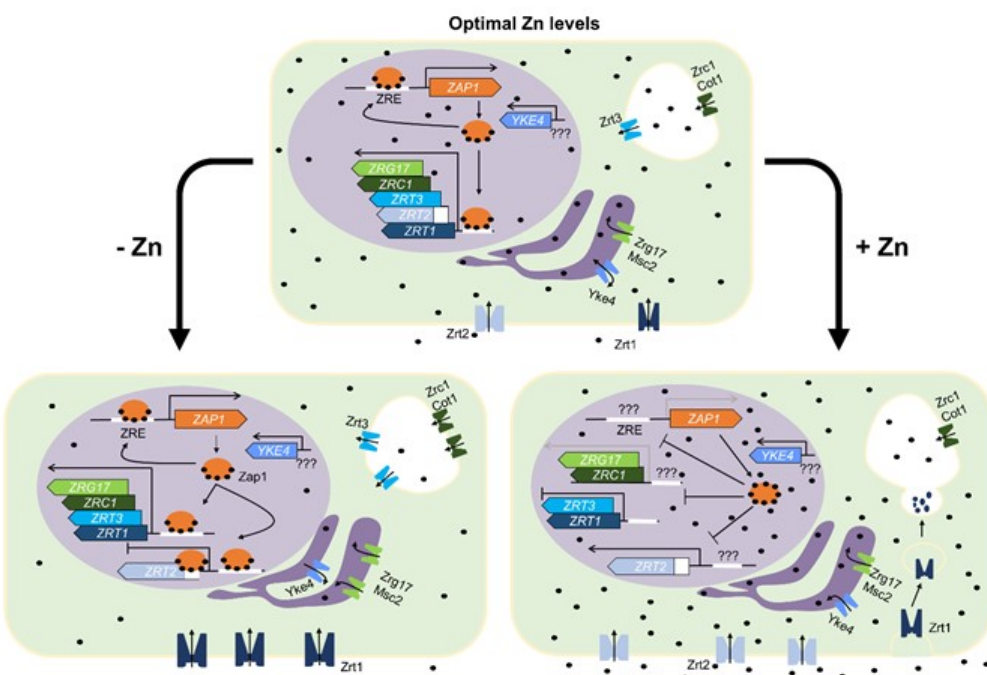
Figure 1. Zinc homeostasis mechanisms in Saccharomyces cerevisiae . Zinc is represented by black dots. Proteins that transport zinc to the cytosol as well as the correspondent genes are represented by different shades of blue; intracellular zinc transporters and genes are represented by shades of green. At optimal zinc levels, Zap1 (orange circle) induces itself and all transporters at different levels with the exception of Yke4 (regulation currently unknown), Msc2, and Cot1 (not Zap1-dependent). Under zinc deprivation conditions, Zap1 induces itself as well as ZRG17 , ZRC1 , ZRT3, and ZRT1 genes while repressing ZRT2 by binding to the zinc responsive elements (ZRE) near ZRT2 TATA box (white box upstream ZRT2 ). Zrt1 and Zrt2 are cytoplasmatic membrane transporters, Zrc1/Cot1 and Zrt3 are vacuolar transporters and Zrg17 is part of a complex with Msc2 in the ER. Under excess zinc conditions, Zap1 is inactive and unable to bind to ZREs on target genes. However, ZRG17 and ZRC1 are expressed at reduced levels. ZRT3 and ZRT1 are repressed and ZRT2 is induced by yet to be described mechanisms. Zrt1 is also quickly internalized and degraded in this condition.